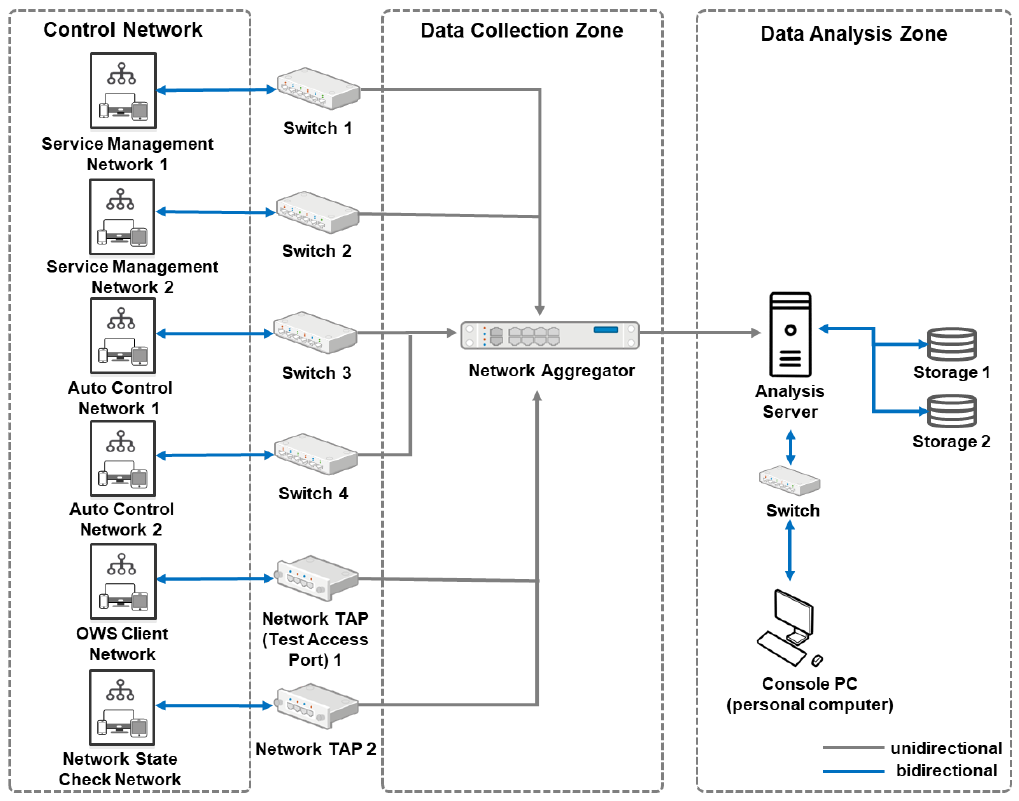
Figure 4. Network configuration for pattern detection.